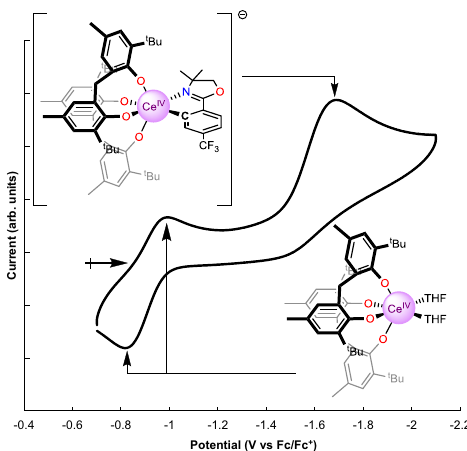
Fig. 4 Cyclic voltammagram of 3-THF. Solvent: THF; electrolyte 0.1 M [ n Pr 4 N][BAr F 4 ]; [analyte] = 0.001 M; OCP = − 0.815 V vs. Fc/Fc + , noted by the right-facing arrow; ν = 100 mV s − 1 . The trace shows the reduction of 3 at E pc = − 1.67 V vs. Fc/Fc + with a return wave at E 1/2 = − 0.94 V vs. Fc/Fc + , which is the Ce III /Ce IV couple of 1 29 . The waves corresponding to 1 do not appear in the fi rst scan (Supplementary Figs. 18 –